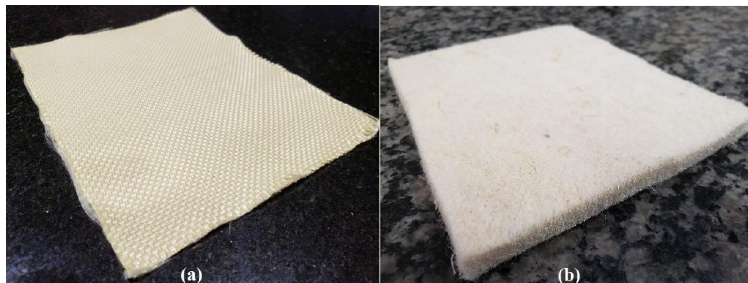
Figure 2. ( a ) Aramid woven fabric and ( b ) curaua non-woven mat.